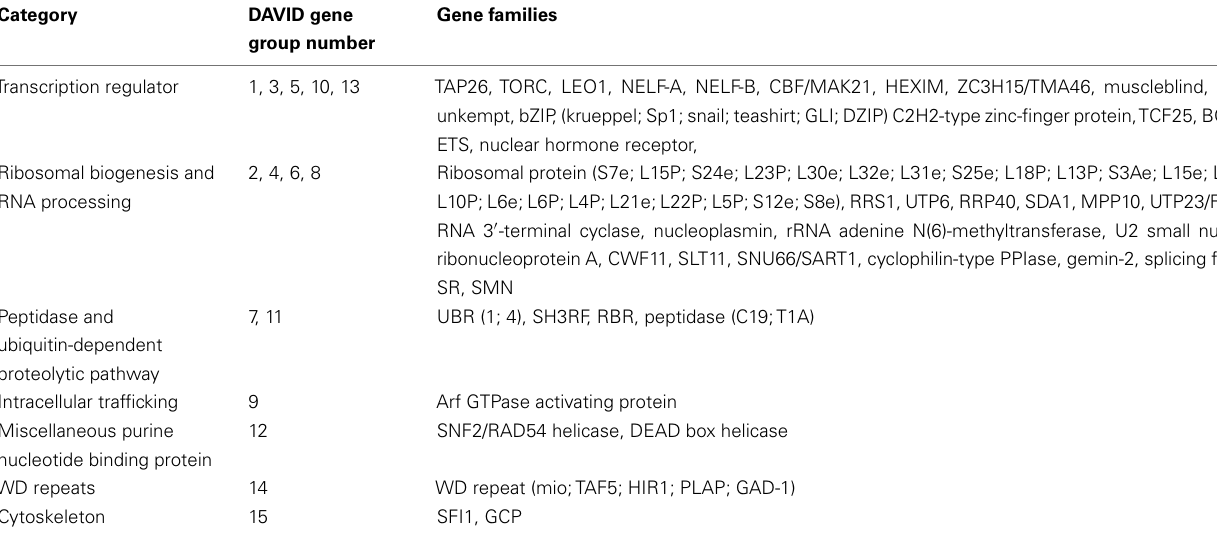
Table 4 | Gene families of down-regulated genes in 14-day hyperglycemic MBL null mice compared toWT control.